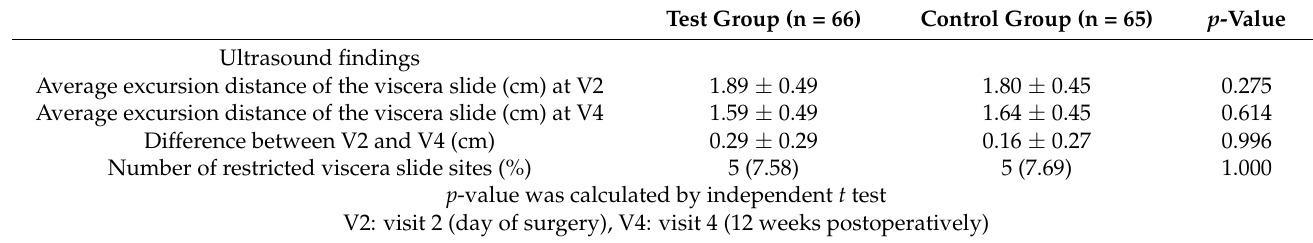
Table 2. Adhesion characteristics in the test and control